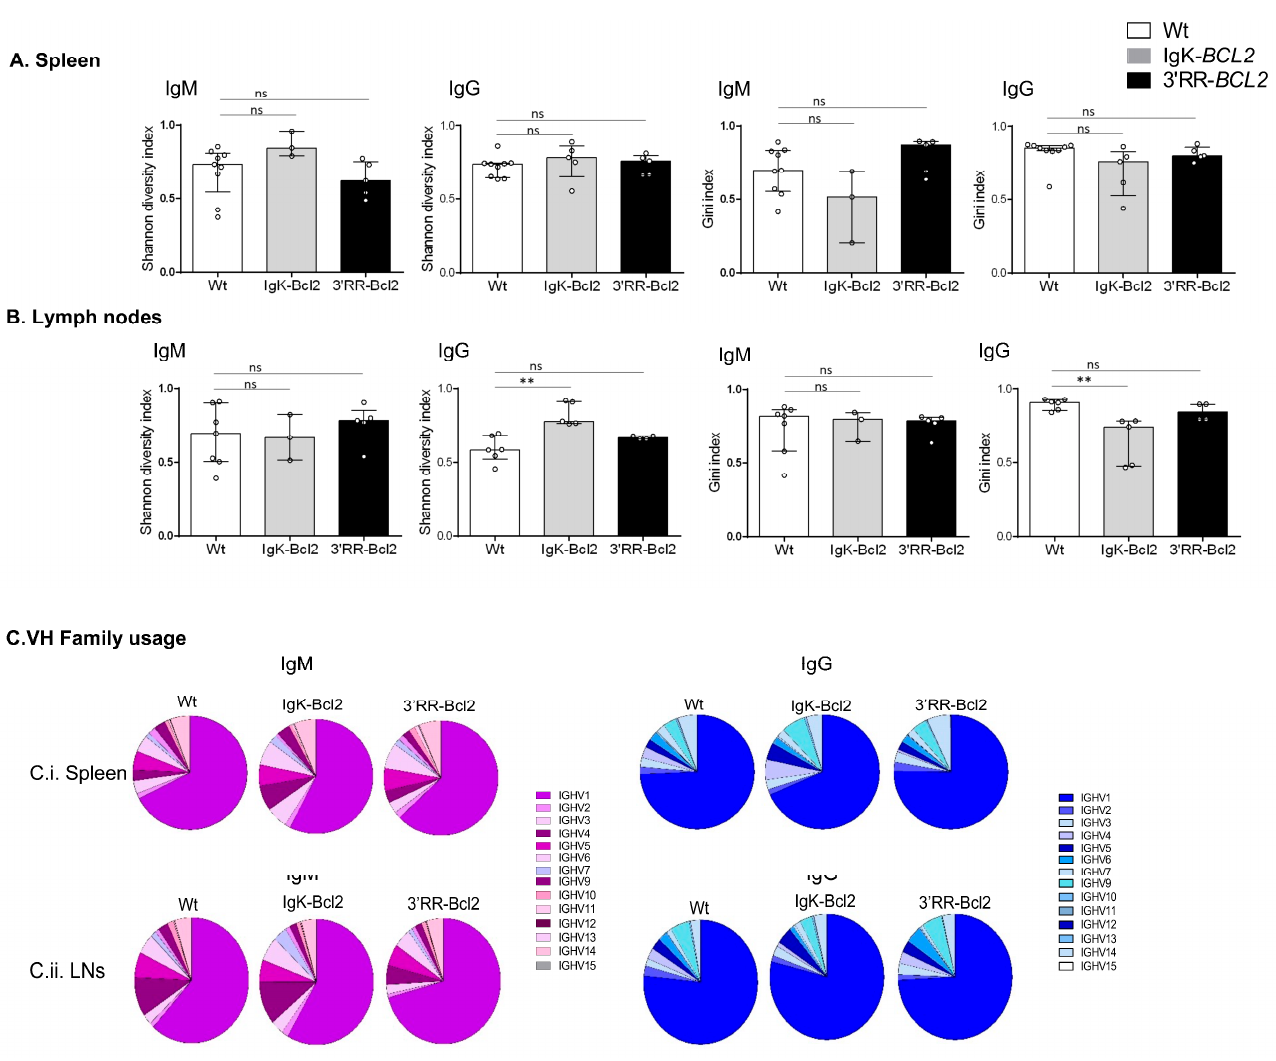
Figure 6. IgH repertoire of immunized mice. Histograms showing the Shannon diversity index and the Gini index of both IgM and IgG repertoires in the spleen ( A ) and mesenteric LNs ( B ) of both BCL2 mouse models compared to WT. Both indices are presented as medians with interquartile range, and statistical significances are determined by Mann–Whitney U test. ( C ) Pie charts showing the mean percentage of each VH gene family usage of both IgM (in purple) and IgG (in blue) in the spleen and mesenteric LNs of both BCL2 mouse models compared to WT. ** p < 0.01; ns, not signifi- cant.